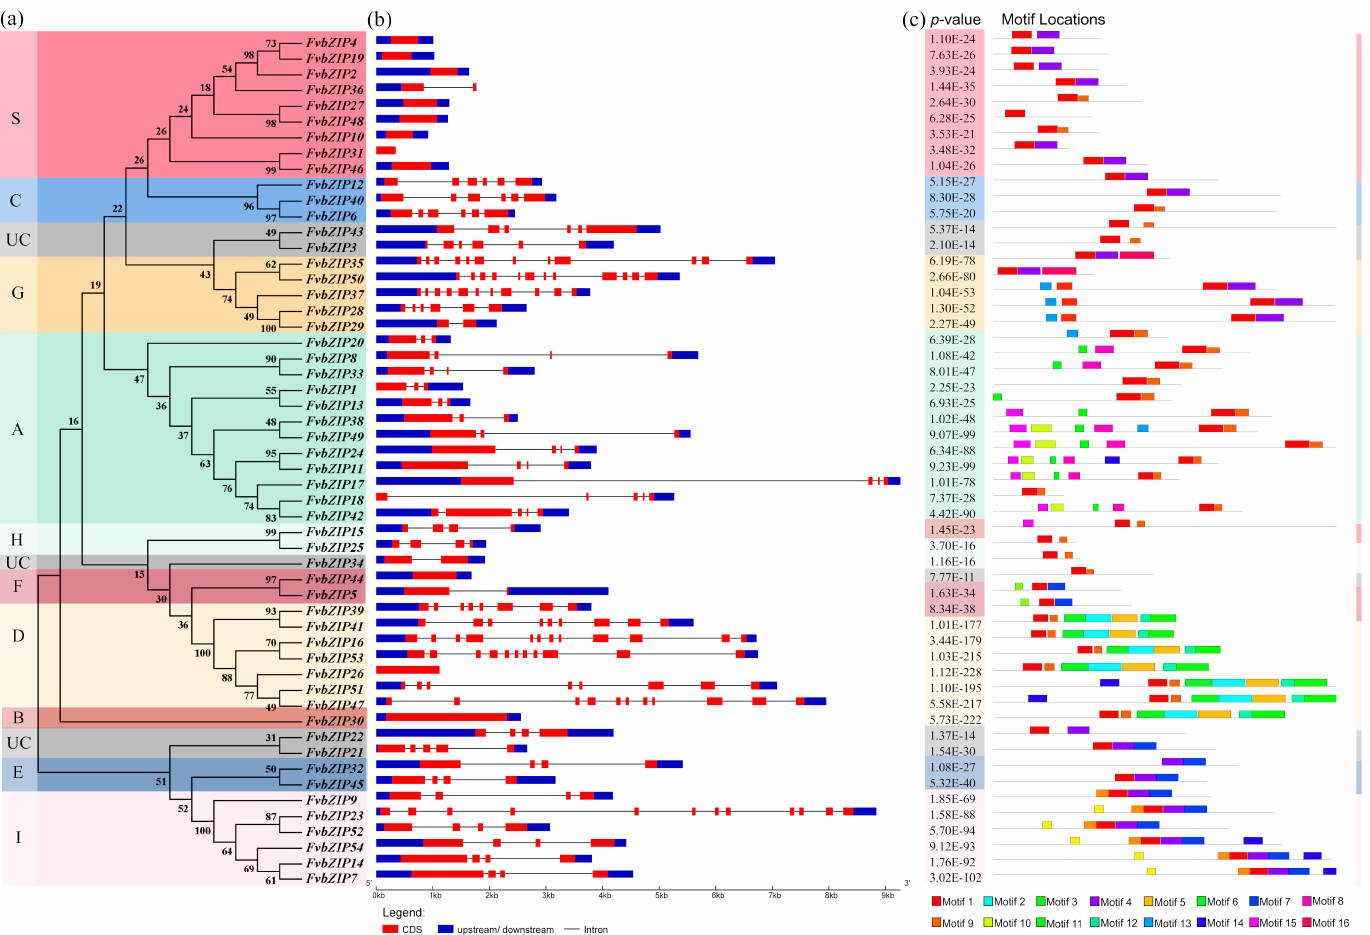
Figure 4. ( a ) Phylogenetic analysis of strawberry bZIP genes. The phylogenetic tree was generated using the amino acid sequences of bZIP proteins via NJ methods. All strawberry bZIP genes were classified into 10 groups. ( b ) Gene structure. Through the website Gene Structure Display Server, the whole genome sequence and CDS sequence of FvbZIP genes were formulated into an information map containing the structure of each FvbZIP gene. ( c ) Motif patterns of strawberry bZIP proteins. The protein sequence of all the strawberry bZIP proteins were entered into the MEME, with the highest motif number set to 20 and the other parameters set to the default.